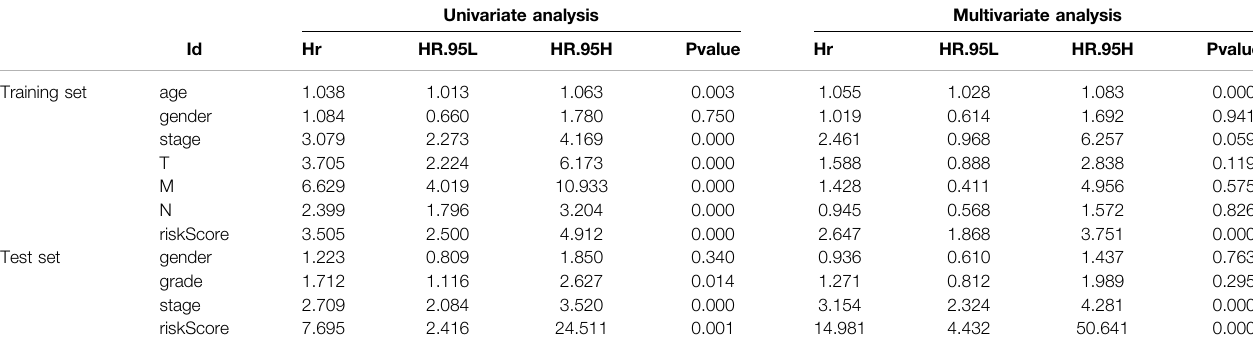
TABLE 3 | Univariate and multivariate Cox regression analysis of the IRGSig and clinicopathologic factors in the training and test